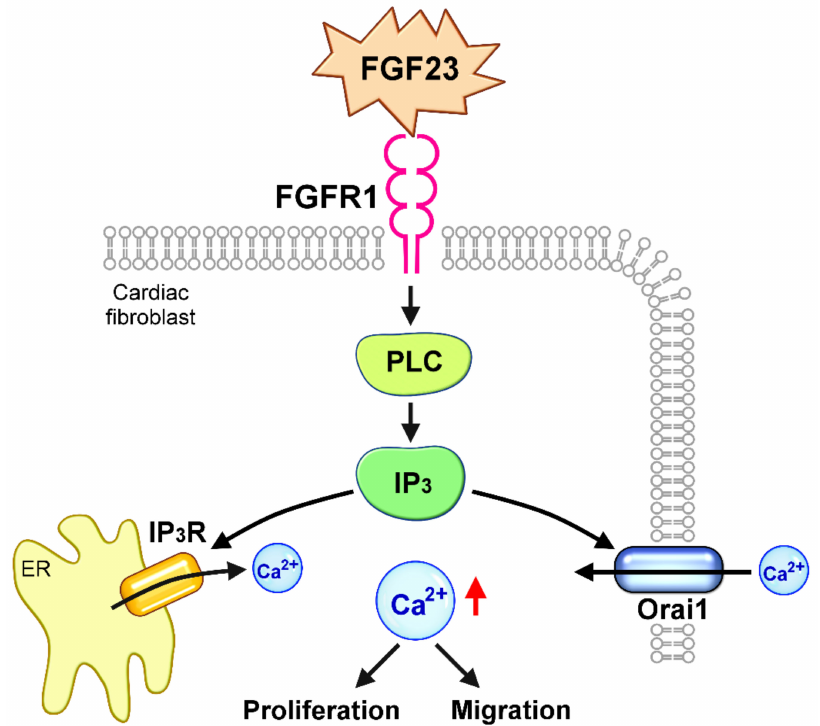
Figure 9. Schematic illustration of the proposed mechanisms underlying the effects of fibroblast growth factor (FGF)-23 on cardiac fibroblast activity. FGF-23 activates FGF receptor 1 (FGFR1) and subsequent phospholipase C (PLC)/ inositol 1,4,5-trisphosphate (IP 3 ) signaling pathway, leading to an upregulation of calcium release-activated calcium channel protein 1 (Orai1)-mediated calcium (Ca 2+ ) entry and IP 3 receptor (IP 3 R)-mediated Ca 2+ release from endoplasmic reticulum (ER), thus stimulating cardiac fibroblast proliferation and